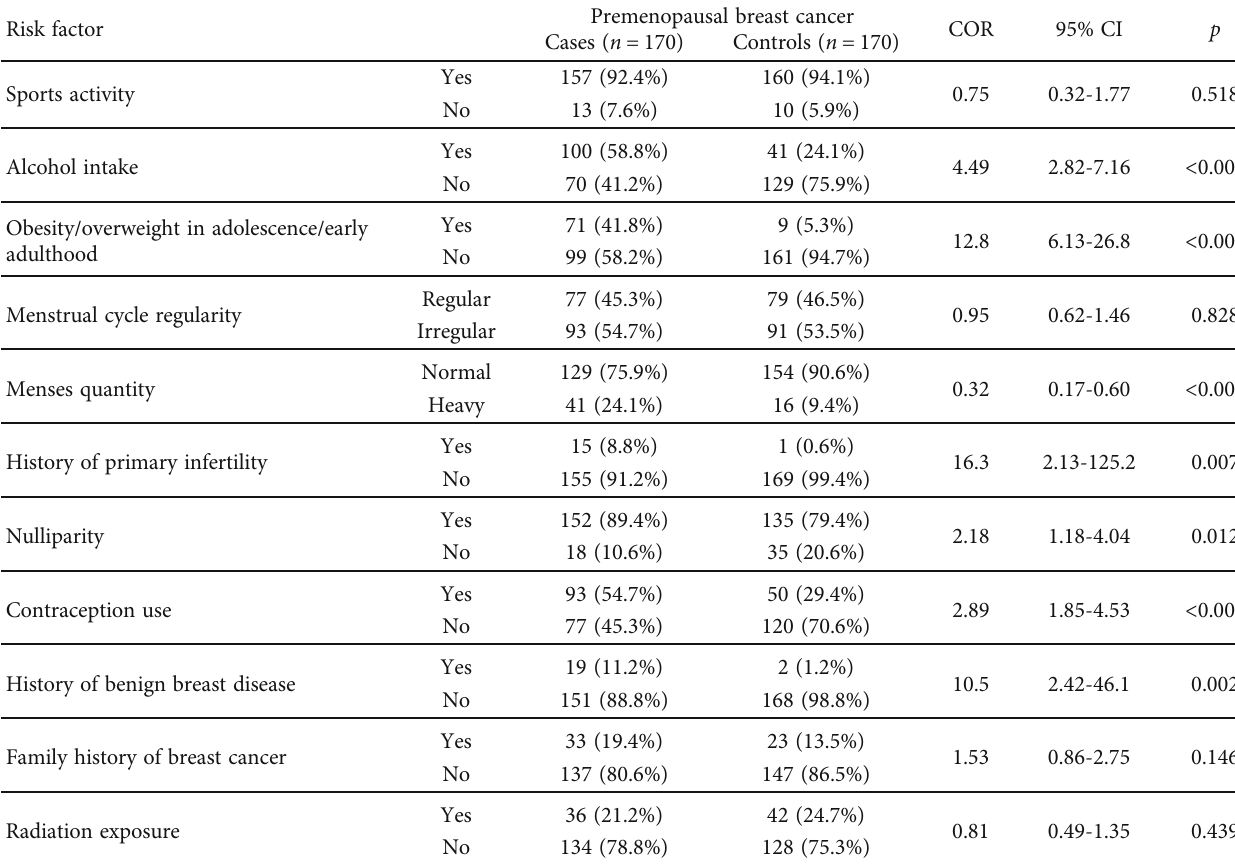
Table 2: Associations between exposure and premenopausal breast cancer.